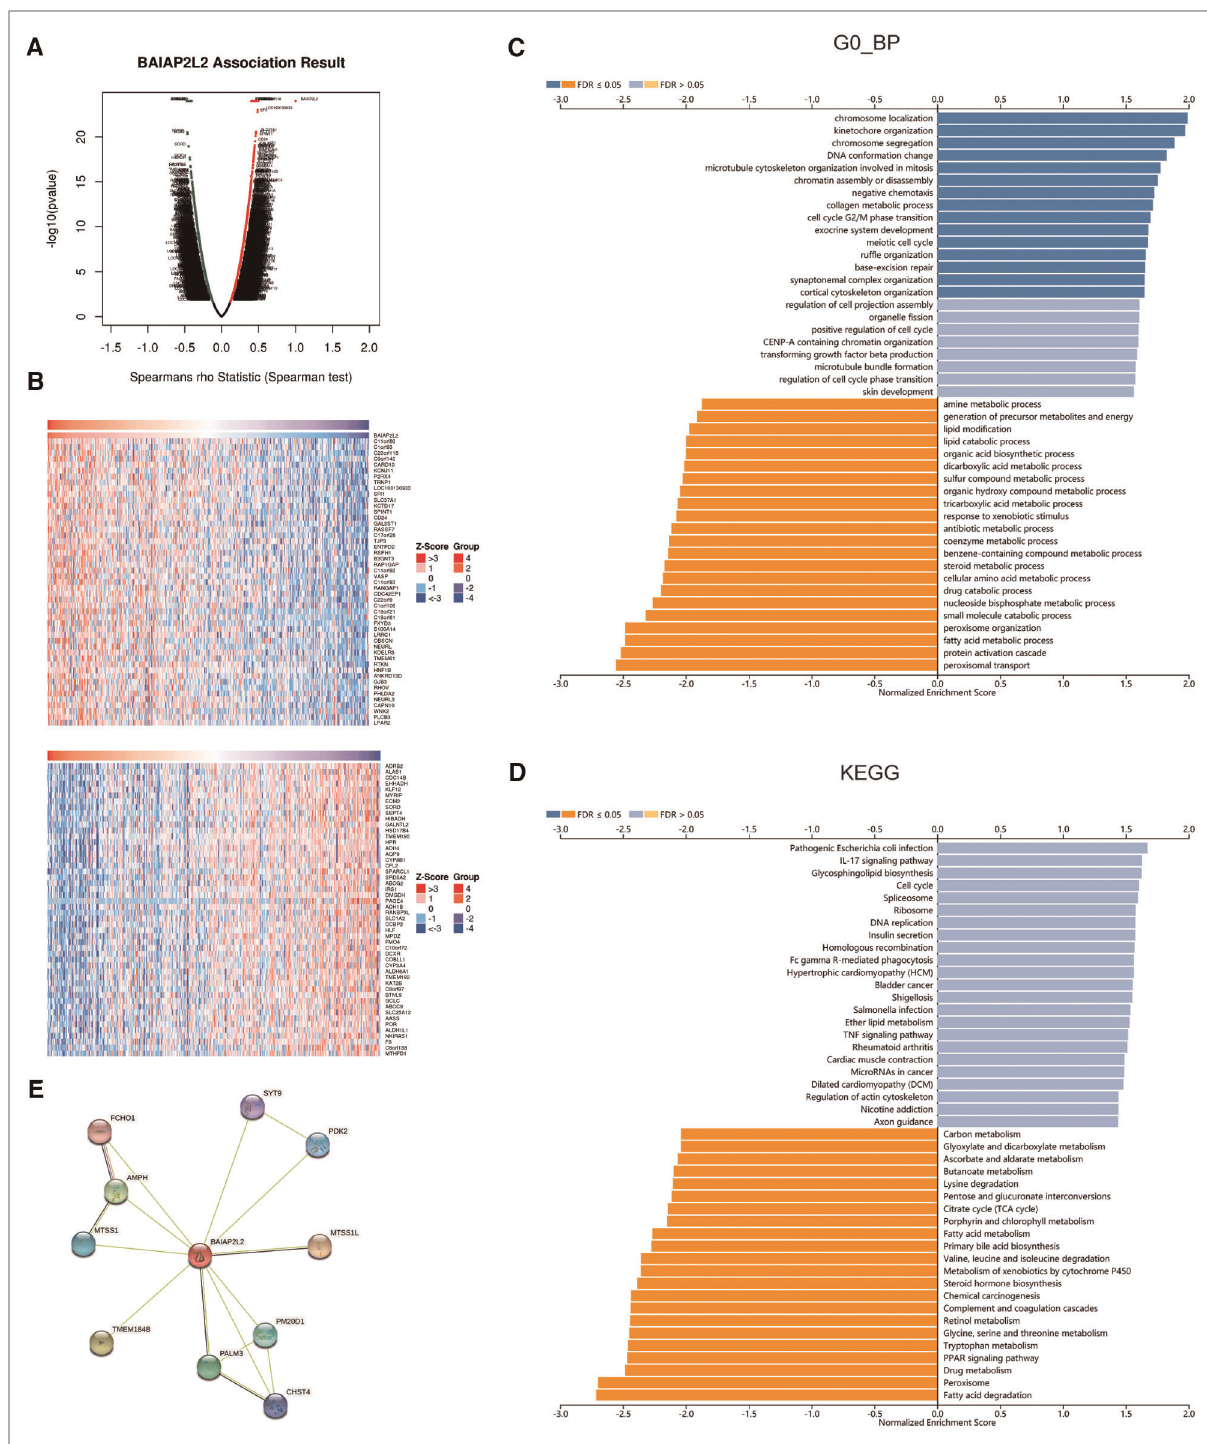
FIGURE 7 Genes and proteins coexpressed with BAIAP2L2 in LIHC from the LinkedOmics database. ( A ) Highly correlated genes identi fi ed by the Pearson test in the LIHC cohort. ( B ) Heat maps showing the top 50 genes positively and negatively correlated with BAIAP2L2 in LIHC (red: positively correlated genes; blue: negatively correlated genes). ( C,D ): Signi fi cantly enriched GO annotations and KEGG pathways of the genes coexpressed with BAIAP2L2 in LIHC. ( E ) A PPI network of BAIAP2L2 was generated using the STRING